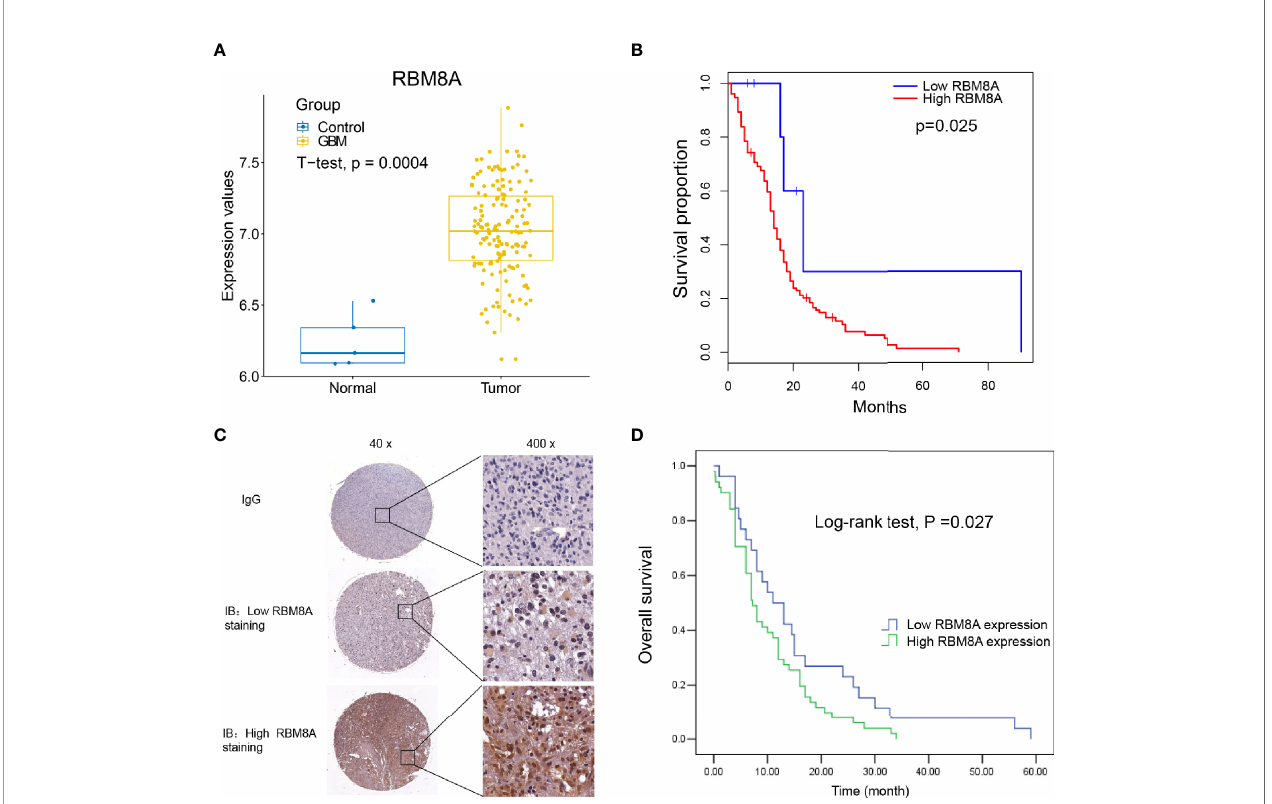
FIGURE 1 | Up-regulated RBM8A expression levels suggest an unfavorable prognosis in GBM. (A) RBM8A was up-regulated in GBM based on The Cancer Genome Atlas. (B) Kaplan-Meier curves for the GBM samples in TCGA based on optimal gene expression grouping. GBM patients with high expression of RBM8A showed poor prognosis. (C) Representative images from immunohistochemical staining of tumor sections from GBM patients. Immunoglobulin (IgG) was used as a negative control. Magni fi cation: 40× or 400×. Representative photographs show low or high RBM8A expression in GBM tissues. (D) Kaplan-Meier curves of overall survival for patients whose tumors showed low or high RBM8A